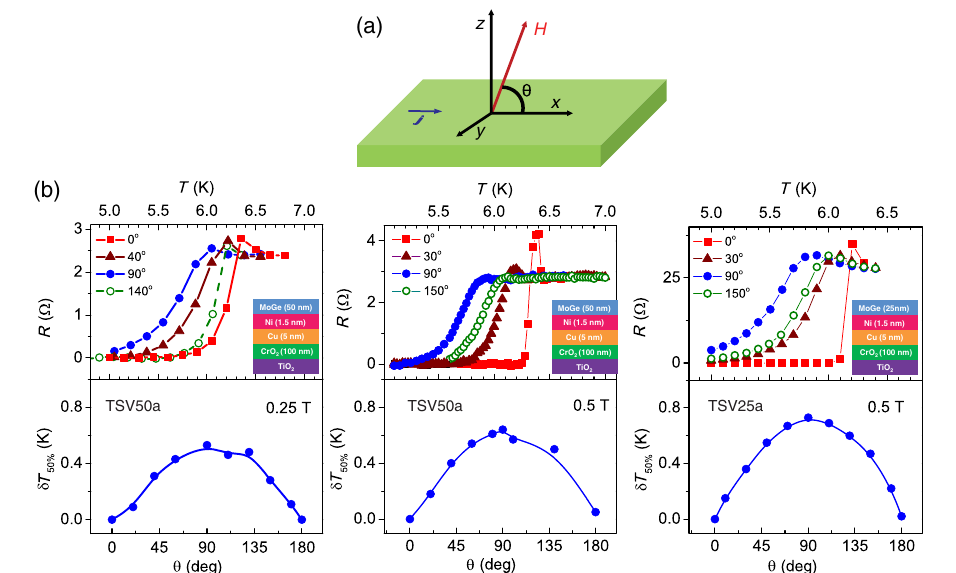
FIG. 2. Colossal triplet spin valve effect. (a) Coordinate system used in angle-dependent magnetotransport measurements, showing the direction of the current j , the applied field H a , and the angle θ between them. (b) Spin valve effect in the two spin valves MoGe ð d s Þ = Ni ð 1 . 5 nm Þ = Cu ð 5 nm Þ = CrO 2 ð 100 nm Þ with d s ¼ 5 nm (TSV50a, left and middle) and d s ¼ 25 nm (TSV25a, right). Upper panels: Resistive transitions for different θ as indicated. Lower panels: Variation of δ T 50% ¼ T 50% , ð 0 ° Þ − T 50% , ð θ Þ as a function of θ at 0.25 T (TSV50a) and 0.5 T (TSV50a, TSV25a), where T 50% is the temperature where the normal state resistance has decreased by 50%. Note that a peak appears in the transition curves for measurements at θ ¼ 0 °.